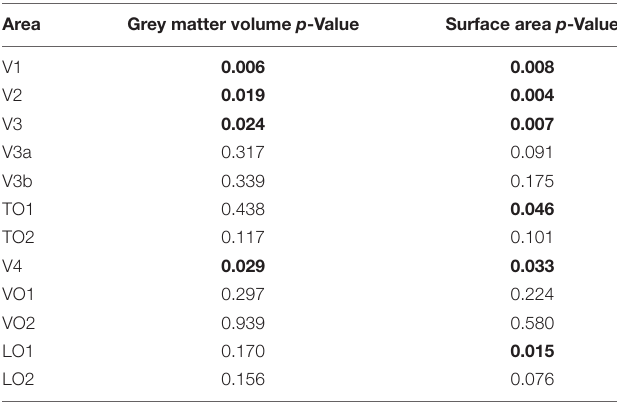
TABLE 3 | Post hoc between group comparisons following analysis of variance in Table 2 , Bonferroni-corrected.